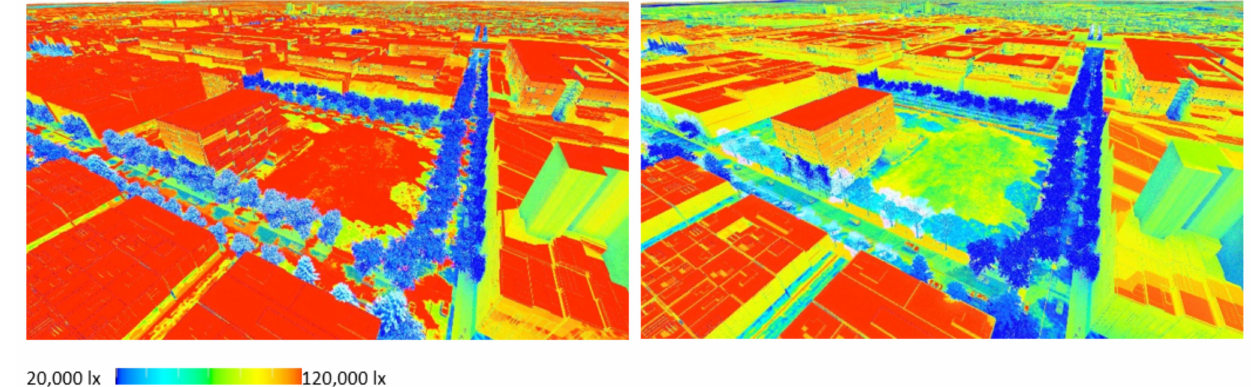
Figure 23. Rapid lux level lighting calculation for winter (left)/summer (right) seasonal comparison. Image by authors using multi-criteria street tree design decision support modelling approach in Autodesk™ 3ds